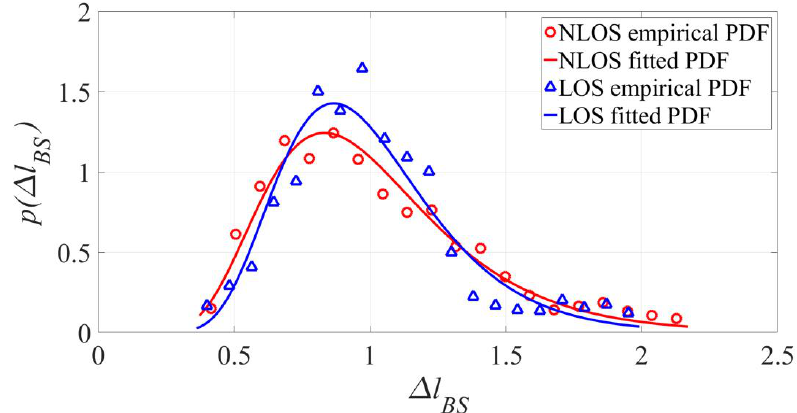
Figure 4. Exemplary results of the lognormal probability density functions fitted to empirical large-scale fading distributions (for DEP, HE R , NB).